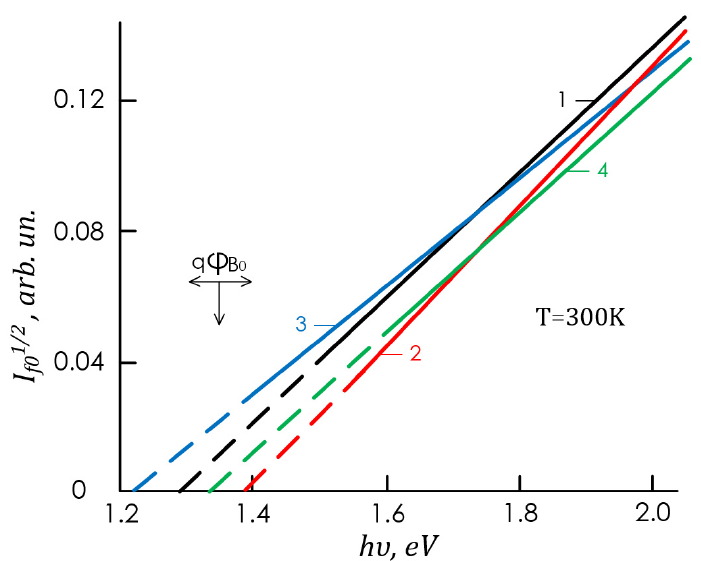
Figure 2. Dependencies of photocurrent I f01/2 related to equality of incident photons on photon energy h ν for four Au-Pd-n-GaP surface-barrier structures with different thicknesses of the intermediate palladium layer d. d: 1—40 Å, 2—32 Å, 3—45 Å, and 4—22 Å. Here and below, we indicate sample numbers near the curves and correspond to the